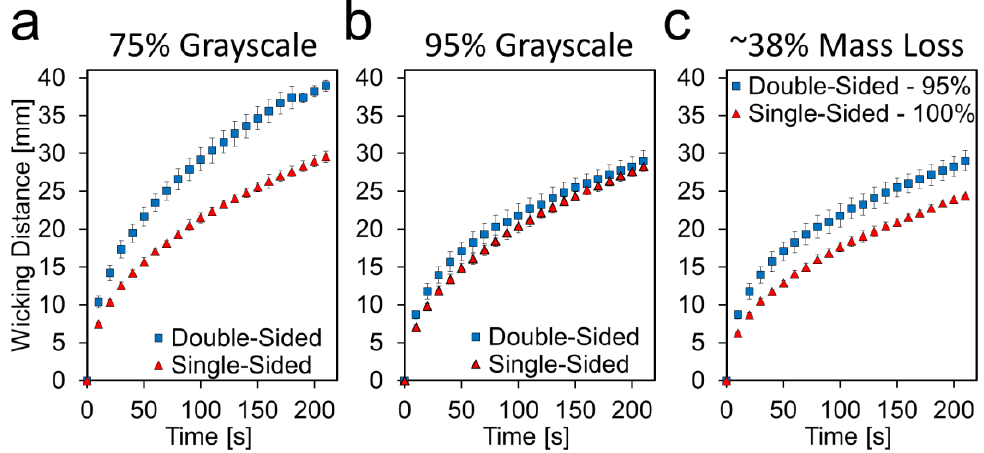
Figure 5. Average wicking distance vs. time at select etching levels of both single- and double-sided etched paper. ( a ) Single- and double-sided paper both etched at 75%. ( b ) Single- and double-sided paper both etched at 95%. ( c ) Single-sided paper etched at 100% and double-sided paper etched at 95% both result in ~38% mass loss, however the double-sided channels are faster, indicating that the speed increase is more than just a function of the total mass removed. Data presented as mean ± SD. n = 3.